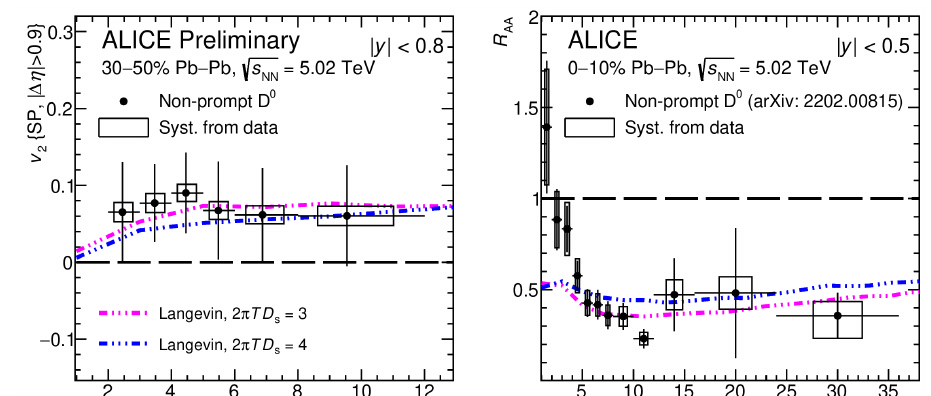
Figure 3. Prompt and non-prompt D 0 meson v 2 in semi-central (30–50%) Pb–Pb collisions at √ s NN = 5.02 TeV.